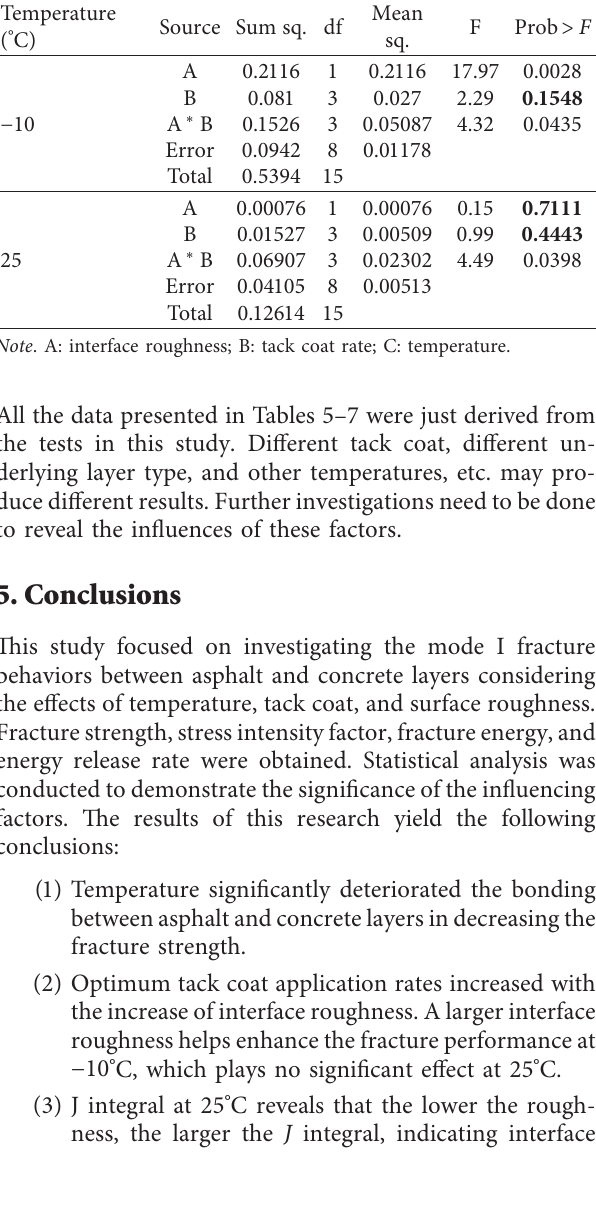
Table 6: Two-way ANOVA results of specimens with different surfaces. Surface Source Sum sq. df condition Unmilled surface Total 45.7077 15 Milled surface